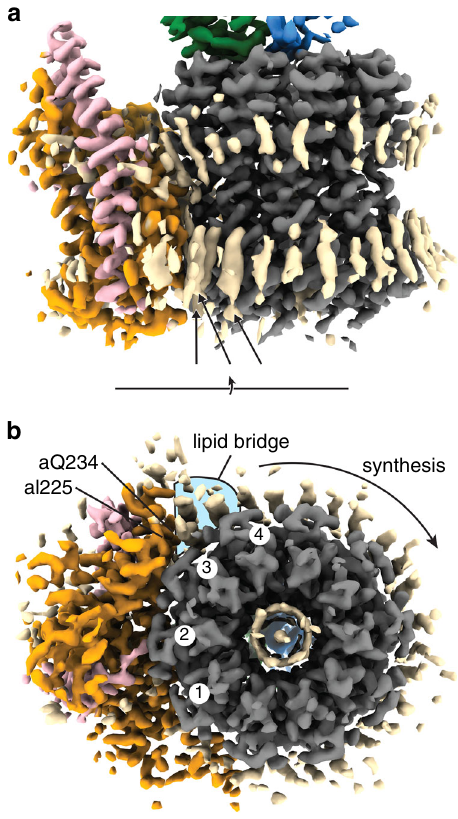
Fig. 5 Lipid bridges contribute to the stator/rotor interaction. Cryo-EM density of Sub-state 3 A, centered on the F o region. Density corresponding to lipids (colored in wheat) “ bridge ” the interaction between subunits a (orange) and c (gray). a When viewed from within the membrane, density can be seen for lipids around the F o motor. Three lipid-like densities on the periplasmic side (labeled with black arrows) are the strongest of these densities, suggesting that they are well ordered. b When viewed from the periplasmic side (view rotation axis shown), the interaction between residues Ile225 – Gln234 of the stator subunit a and c ring is facilitated by three lipid densities (highlighted with blue background), increasing the interaction to four rather than three c subunits (numbered one white